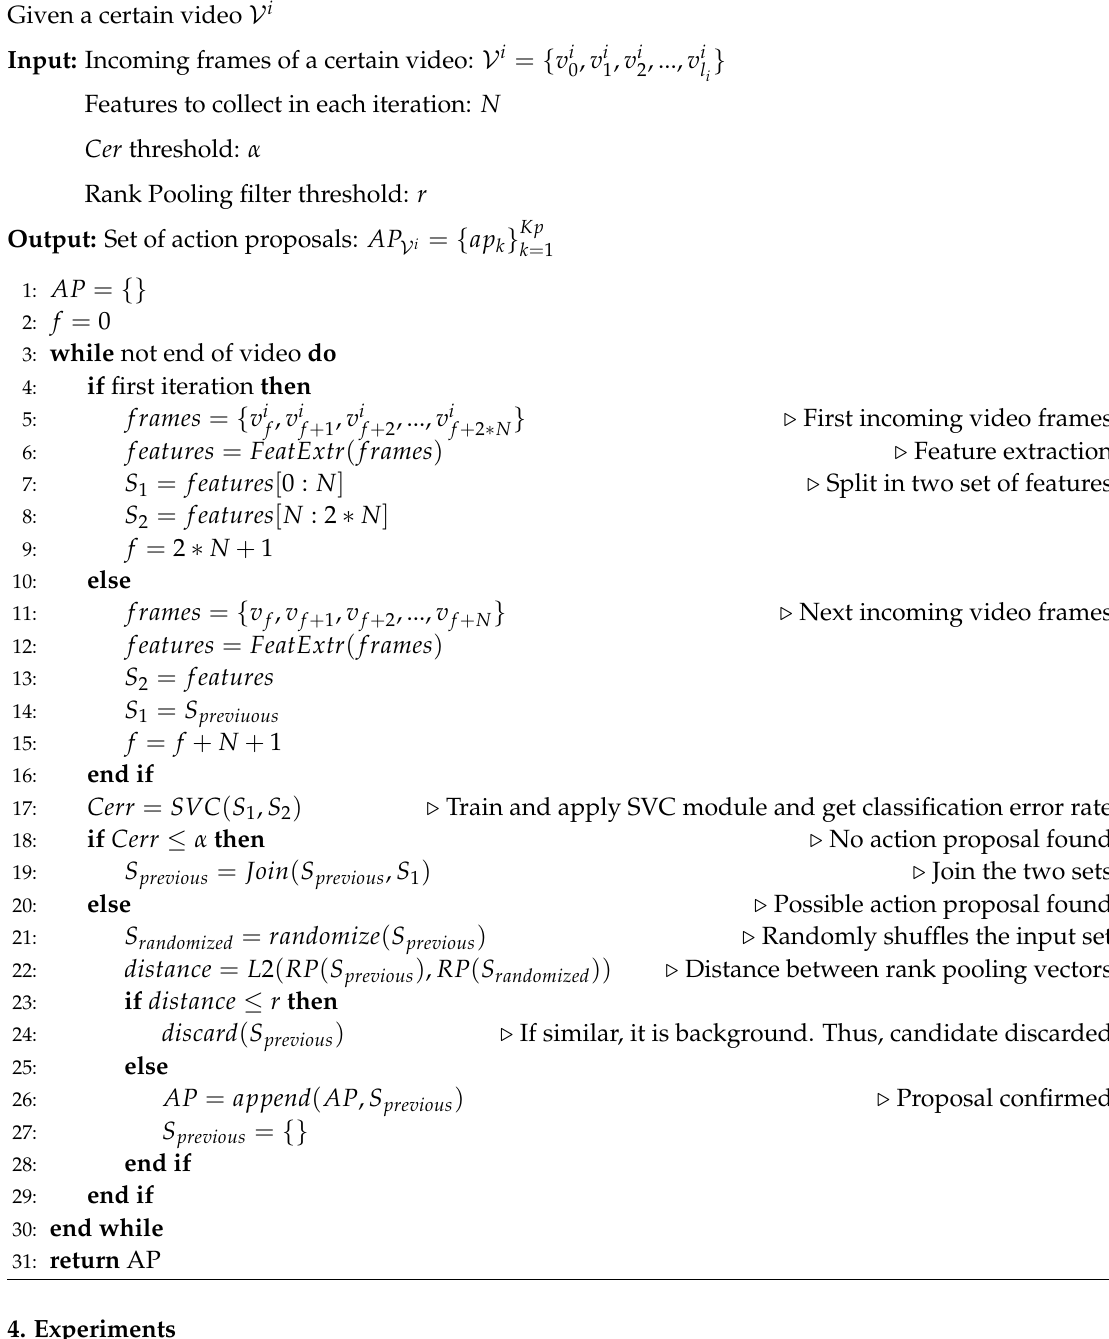
Algorithm 1 SVC-UAP method on a certain video to obtain its action proposals Given a certain video V